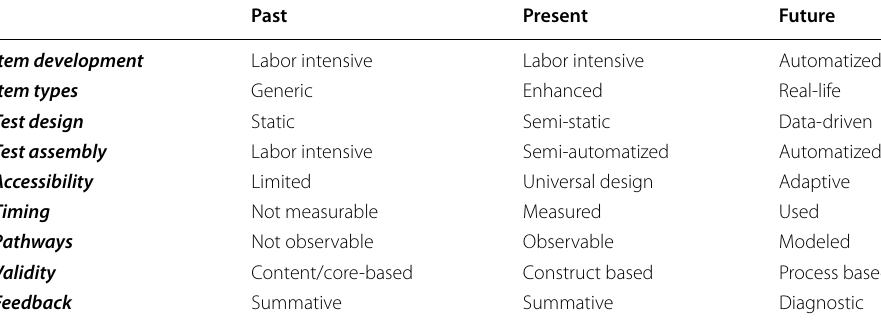
Table 1 Ongoing evolution in